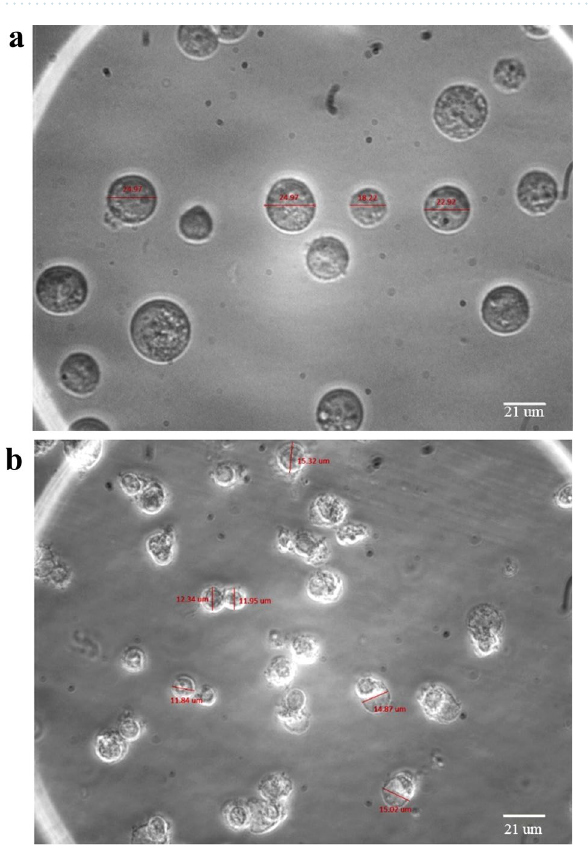
Figure 6. Simulated trajectories of 23 µm-particles (as MCF-7s) in red lines and 14 µm-particles (as L929s) in blue lines at the end of the hybrid design of separator at the rotational speed of 2100 rpm.